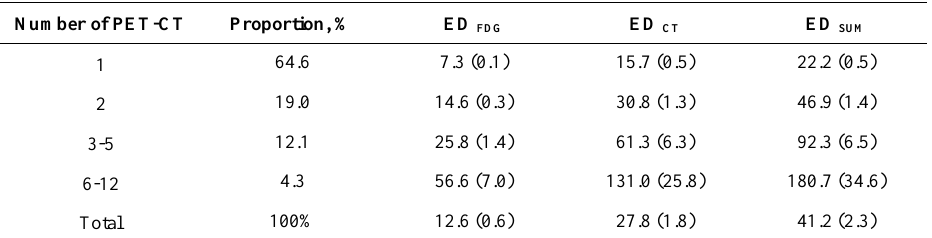
Table 2. Mean effective dose (ED) by number of